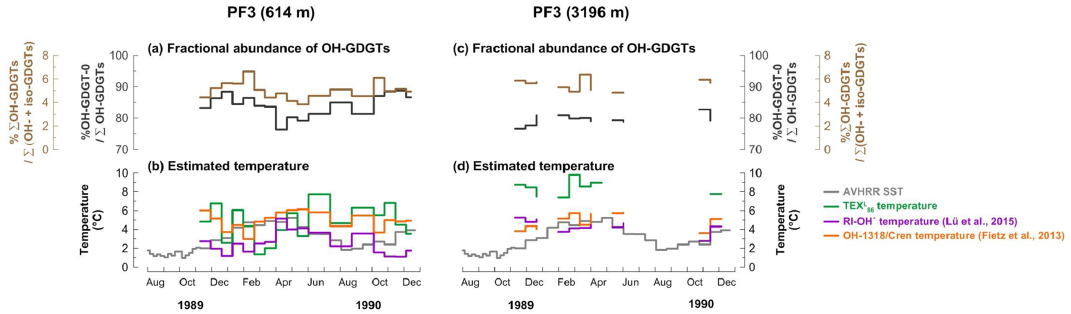
Figure 6. Changes in fractional abundance of OH-GDGTs (a, c) and estimated temperatures based on OH-related calibrations (b, d) at site PF3. The purple and orange lines indicate the calculated temperatures using the calibrations by Fietz et al. (2013) (Eq. 4) and Lü et al. (2015) (Eq. 6), respectively. The green lines indicate the TEX L -derived 86